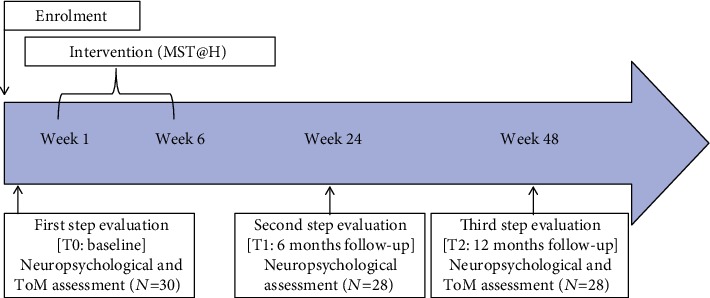
Timeline of the longitudinal study. MST@H = multistimulation treatment at home program.